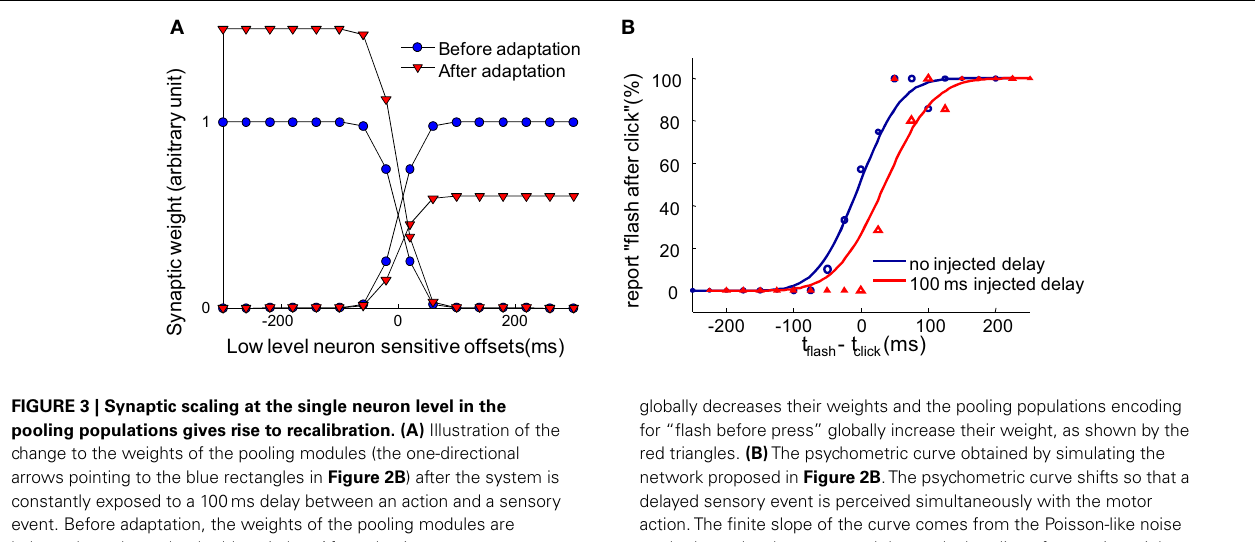
FIGURE 3 | Synaptic scaling at the single neuron level in the pooling populations gives rise to recalibration. (A) Illustration of the change to the weights of the pooling modules (the one-directional arrows pointing to the blue rectangles in Figure 2B ) after the system is constantly exposed to a 100ms delay between an action and a sensory event. Before adaptation, the weights of the pooling modules are balanced, as shown by the blue circles. After adapting to a constant positive delay, the pooling populations encoding for “flash after press”